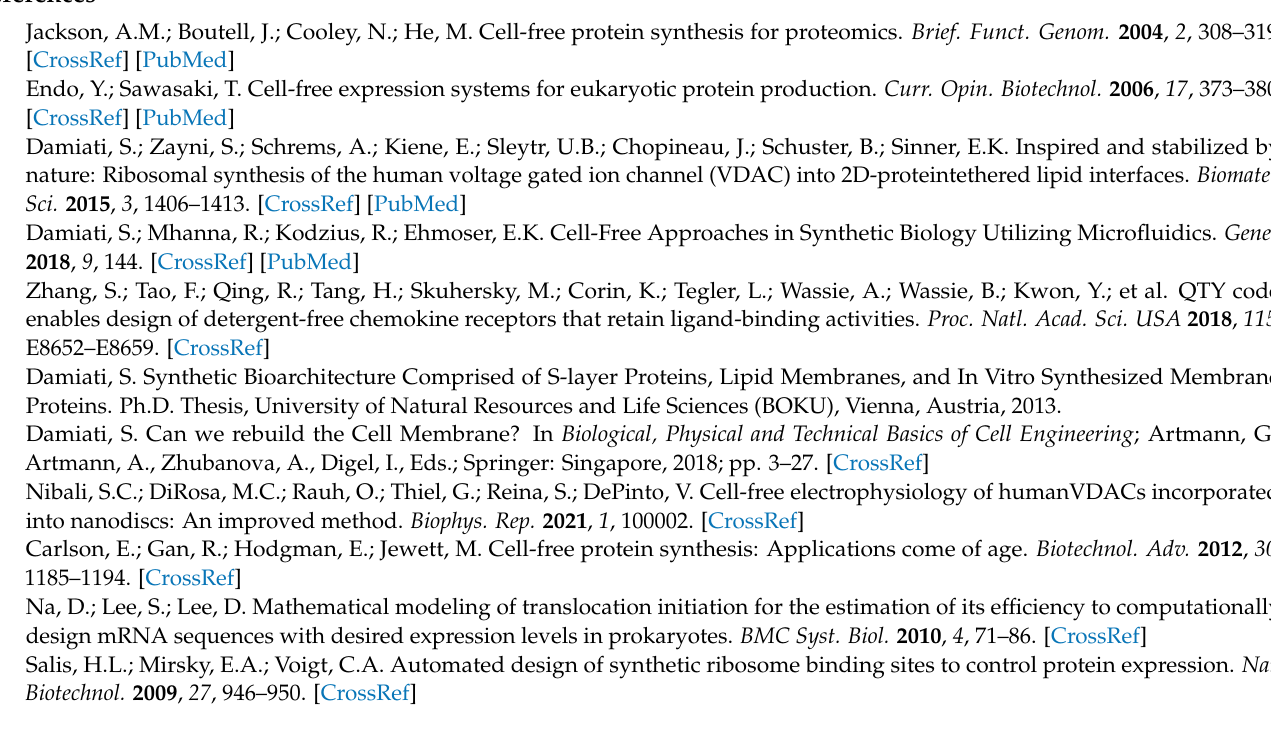
qPCR VDAC specific primer pairs. Figure S1: MALDI-TOF-MS spectrum of VDAC showing the tryptic peptides. Figure S2: MS/MS spectra of two parent ions corresponding to the two highest peaks of the MS spectrum (Figure S1). Figure S3: Western blots of VDAC expression in E. coli . Figure S4: Coomassie staining of the constructs VDAC-I (A–C) (a) and VDAC-II (A–G) (b). Figure S5: Western blot showing the level of protein expression for the constructs VDAC-I (I-A, I-B, I-C) and VDAC-II (II-A, II-B, II-C, II-D, II-E, II-F, and II-G). Table S3: Number of amino acids and the corresponding molecular weight (MW) of the resulting protein, based on the construct’s coding sequence. Figure S6: Average opening energies as a function of i, the RDS location for the E. coli (brown curve) and H. sapiens (orange curve)